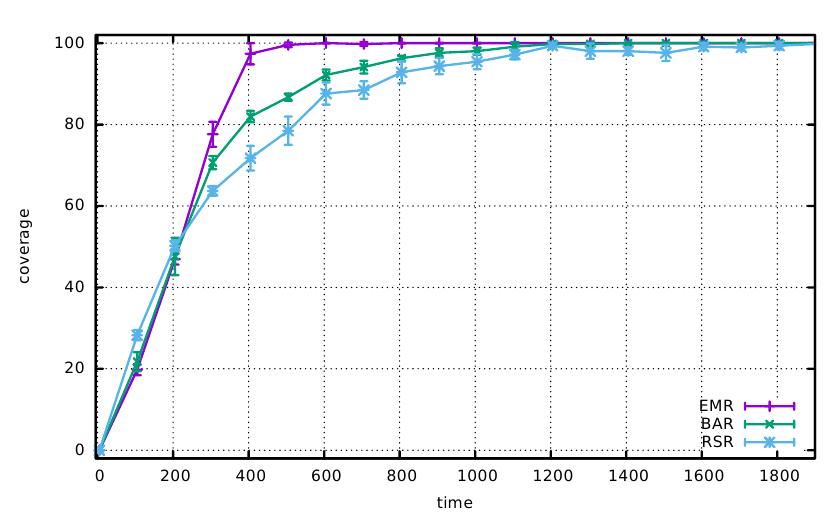
Fig. 12: Comparison of coverage efficiency for the three algorithms before the self-healing process (in average).